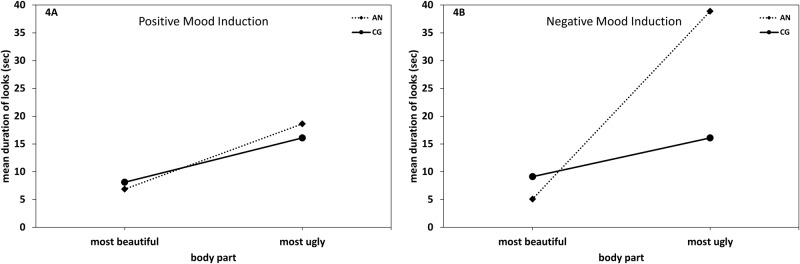
Time spent looking at the most beautiful and most ugly body part in the positive and negative mood conditions.Eye movement pattern in patients with anorexia nervosa (AN) and in the healthy control group (CG). Duration (in seconds [sec]) of looking at the most beautiful/ugly body part in the positive [4A] and the negative [4B] mood induction condition.